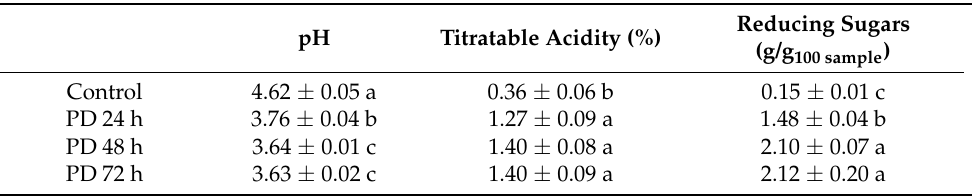
Table 1. The pH, titratable acidity, and reducing sugars for different fermented doughs with Lactiplantibacillus plantarum NRRL